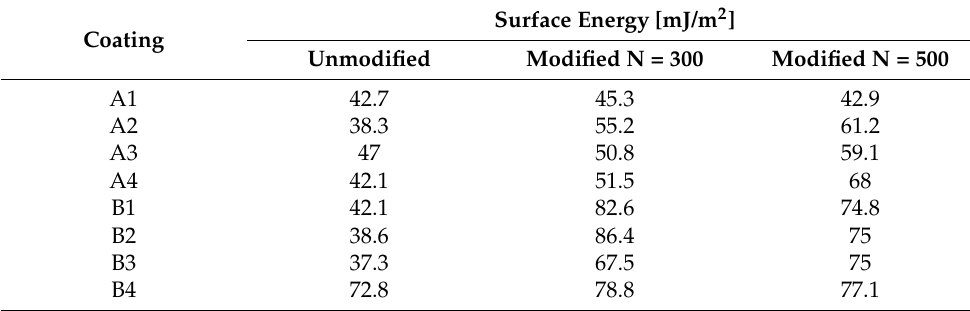
Table 3. Results of surface energy